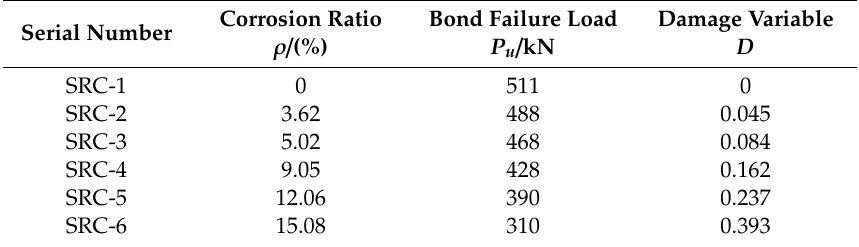
Table 5. Damage variable D under different corrosion ratio.